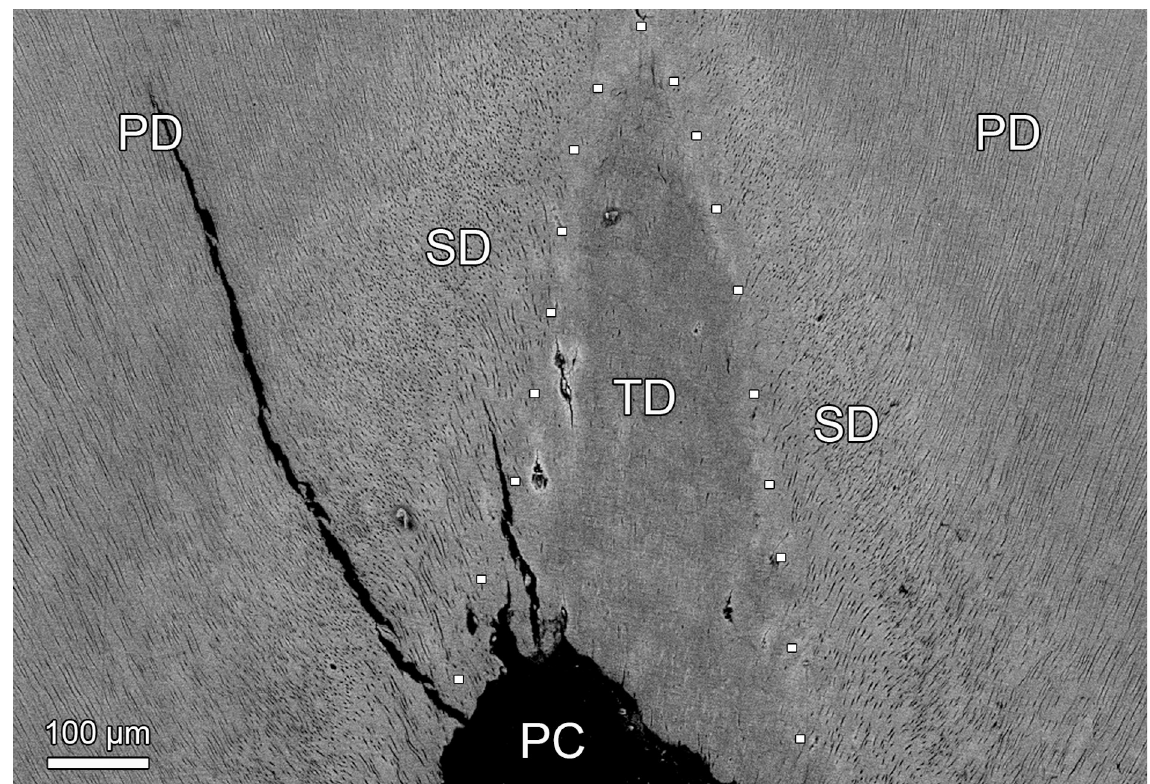
Fig 13. SEM-BSE image of polished cut surface of the bucco-lingually sectioned M 1 of specimen ZMUC 69 3 showing the dentin overlying the pulp cavity. Three types of dentin can be distinguished. The primary dentin (PD) is characterized by regularly arranged, straight dentinal tubules, whereas the tubules in the secondary dentin (SD) are curved and arranged somewhat more irregularly. The tertiary dentin (TD) that has been deposited in the pulp horn exhibits only very few tubules. PC: resin-filled pulp cavity. The stippled line indicates the approximate border between secondary and tertiary